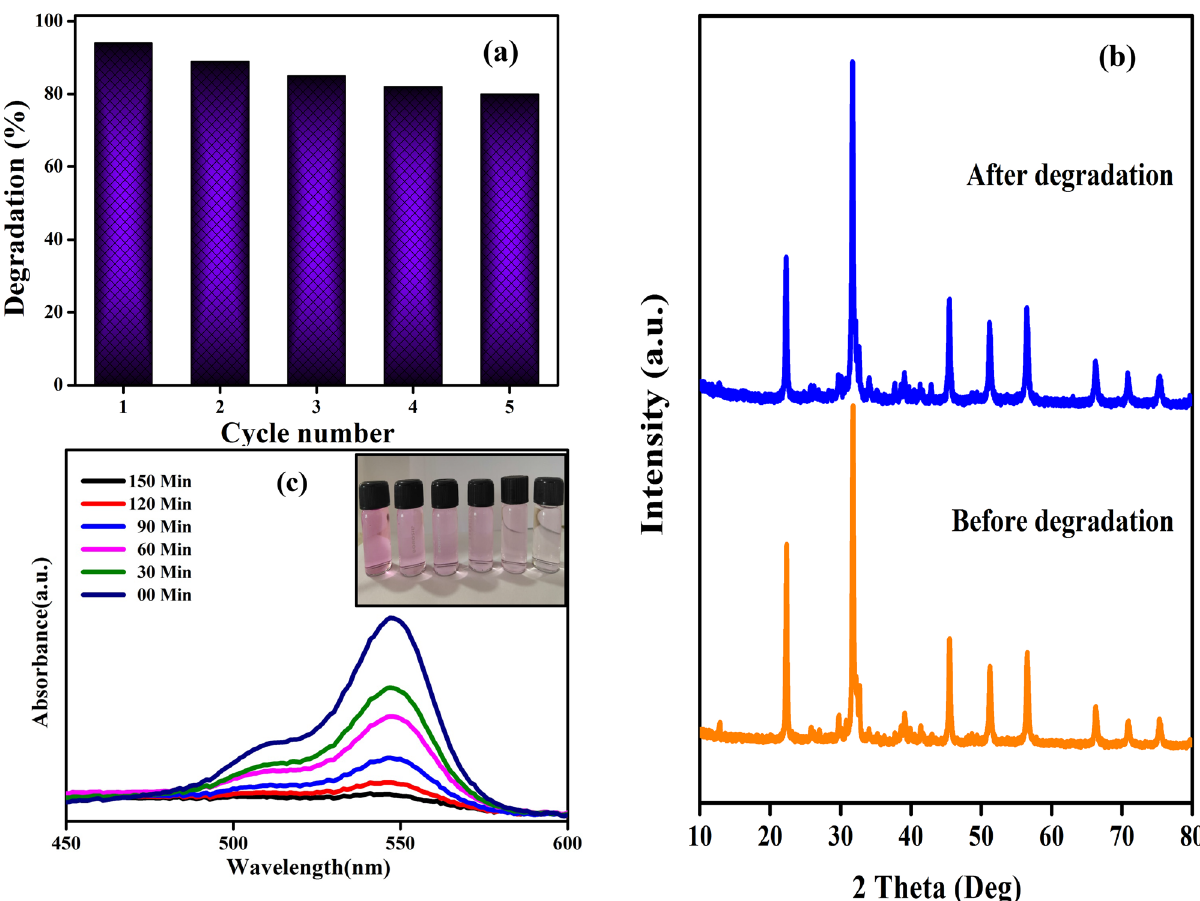
Figure 8. ( a ) Reusability over 5 cycles is achieved with excellent degradation efficiency and ( b ) XRD spectrum showing no change in peaks intensity-before and after degradation of 3D-F-KT (0.4 g concentration of areca seed powder). ( c ) UV–Vis spectra of 0.4 g concentration of areca seed powder 3D-F-KT along with time (Inset: Picture showing effective degradation of Rb